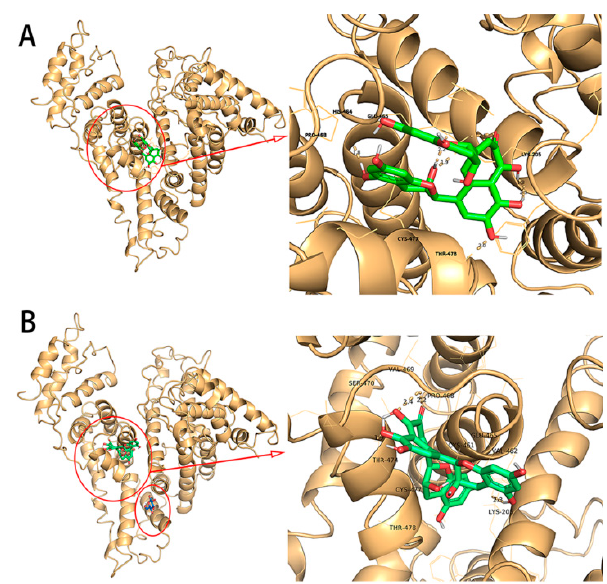
Figure 7. A : Left: The combined orientation map of the lowest docking energy conformation of TF on HSA. Right: a detailed view of the binding mechanism of TF at position 1 and the amino acid residues acting at the binding site. B : Left: Binding orientation map of the lowest docking energy conformation of glucose on HSA. Right: A detailed view of the amino acid residues acting on the binding site of the glucose molecule to the HSA.